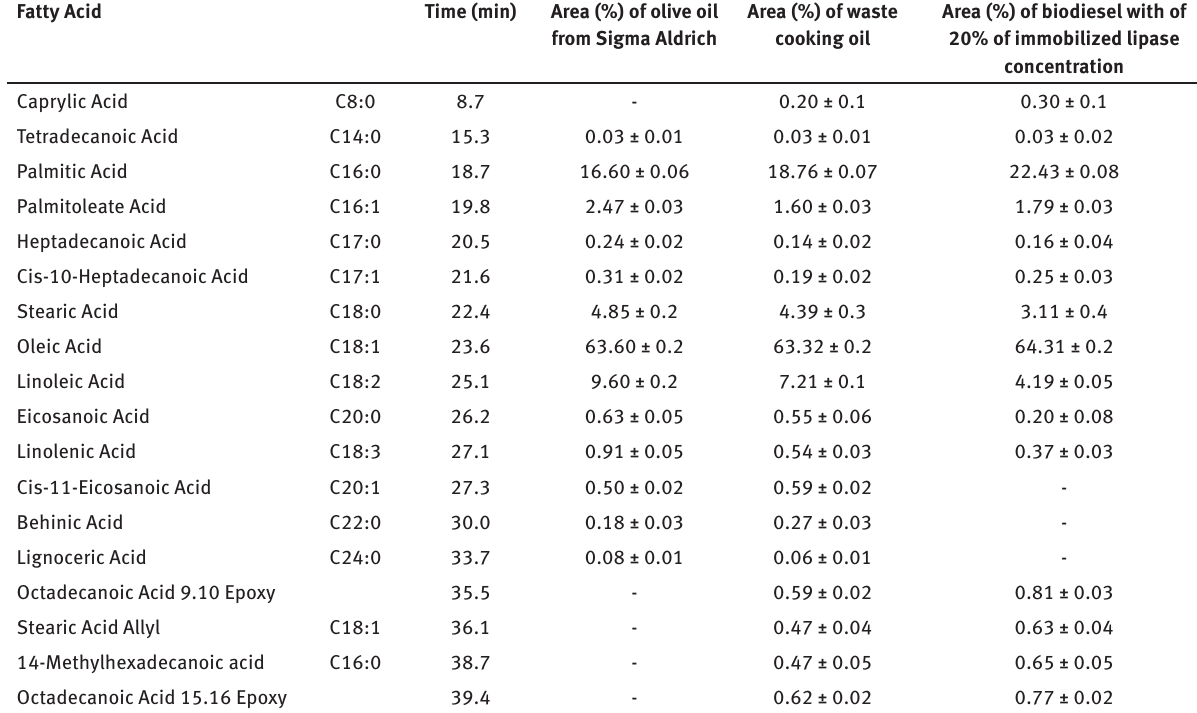
Table 4: Retention times (RT) and area (%) of each fatty acid of olive oil from Sigma Aldrichof waste cooking oil, of biodiesel with of 20% of immobilized lipase concentration. Fatty